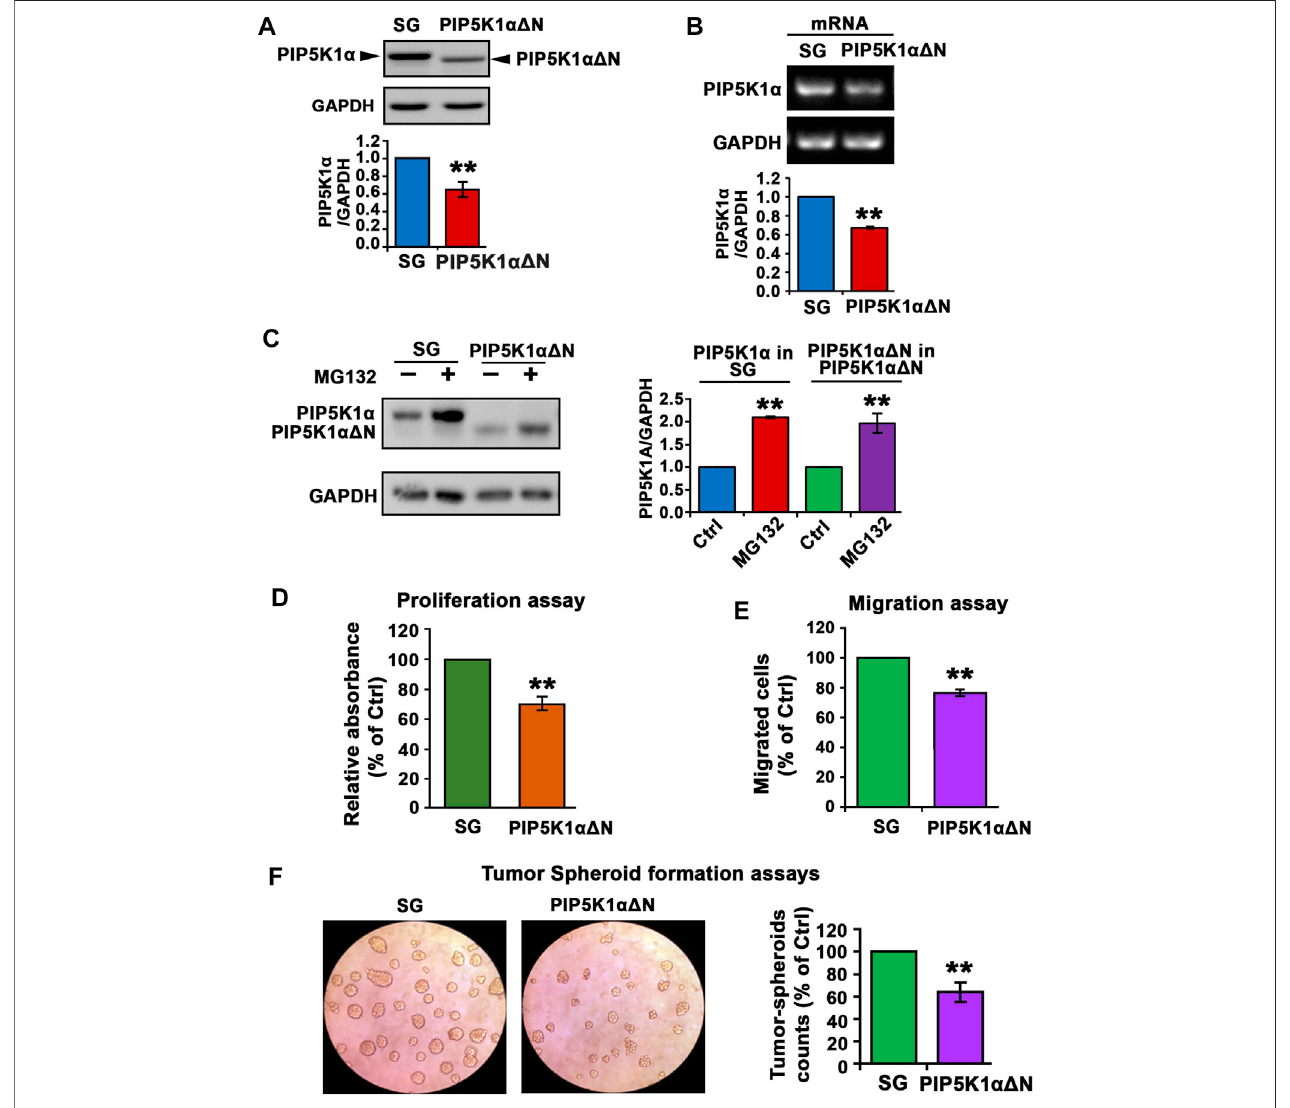
FIGURE 5 | The effect of N-terminal-truncated PIP5K1 α on the proliferation and migratory ability of PIP5K1 αΔ N C4-2 cells. (A) Immunoblot analysis on the expressionoftrunctatedPIP5K1 α inPIP5K1 αΔ NC4-2cells(PIP5K1 αΔ N)orfull-lengthPIP5K1 α inSGC4-2cells(SG)isshown.Theantibodyagainstfull-lengthPIP5K1 α was used. Quanti fi cation of the expression level of PIP5K1 αΔ N and PIP5K1 α in the cells is shown. (B) Representative image of the quantitative RT-PCR to show mRNA expression of WT PIP5K1A and truncated PIP5K1A in SG cells and in PIP5K1 αΔ N cells, respectively. (C) Immunoblot analysis on the expression of PIP5K1 α andPIP5K1 αΔ NinSGcellsandPIP5K1 αΔ NcellsthatweretreatedwithMG132orvehiclecontrol.Quanti fi cationsoftheimmunoblotsforexpressionofPIP5K1 αΔ Nand PIP5K1 α are shown in the right panel. (D) Non-radioactive MTS reagent was used to measure the proliferation rate of SG cells and PIP5K1 αΔ N cells. (E) SG cells and PIP5K1 αΔ N cells were subjected to the trans-well Boyden chamber migration assays. The relative counts of the migrated cells are shown. (F) SG cells and PIP5K1 αΔ N cells were subjected to the tumorspheroid formation assay to assess the single-cell derived tumor-spheroid formation and growth. Representative images of tumor- spheroids derived from SG cells and PIP5K1 αΔ N cells are shown. The relative counts oftumor spheroids from each group are shown. Datain this fi gure is presented as the average of three independent experiments (±SE). Student ’ s t -test was used in the analysis. ** p < 0.01 is indicated.